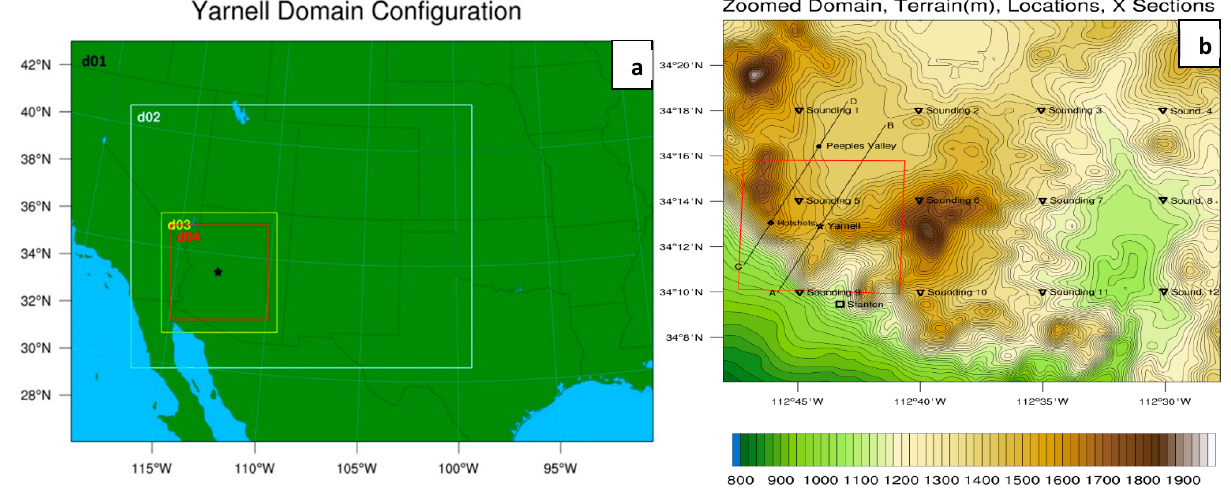
Figure 3. ( a ) Simulation domains: d01 = 7 km, d02 = 2.33 km, d03 = 777 m, and d04 = 259 m. ( b ) Key locations in smooth 900 m low-resolution terrain (fill in m employed for grids d01–d03) as well as soundings, cross-sections, and zoomed-in region for display for d04.